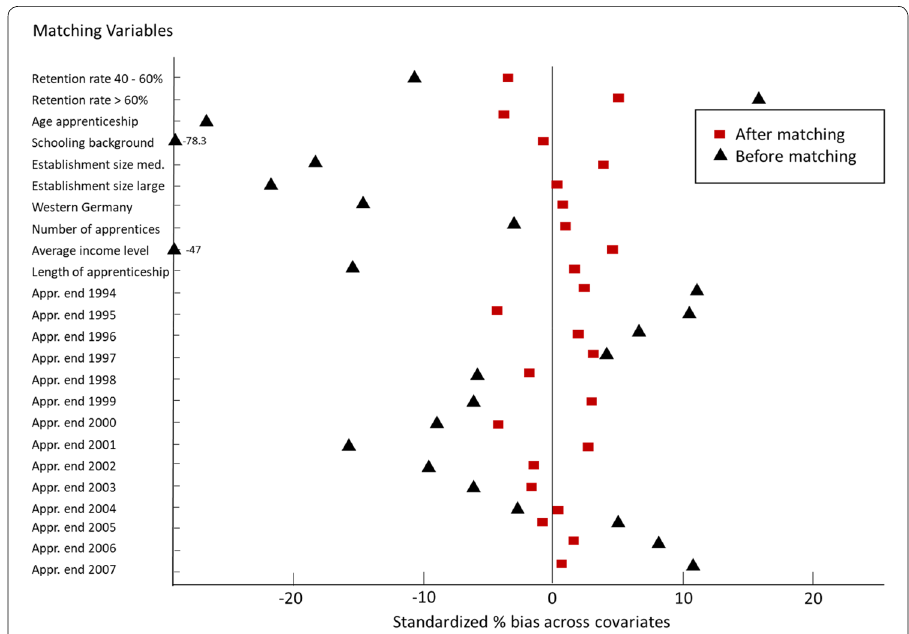
Fig. 2 Differences in characteristics between academics and vocationally trained before (2.213 foremen and 17.062 academics) and after matching (2.079 matches.) Note: occupations on a 2 digit level and 24 economic sections are included in our matching, but not shown in the graph